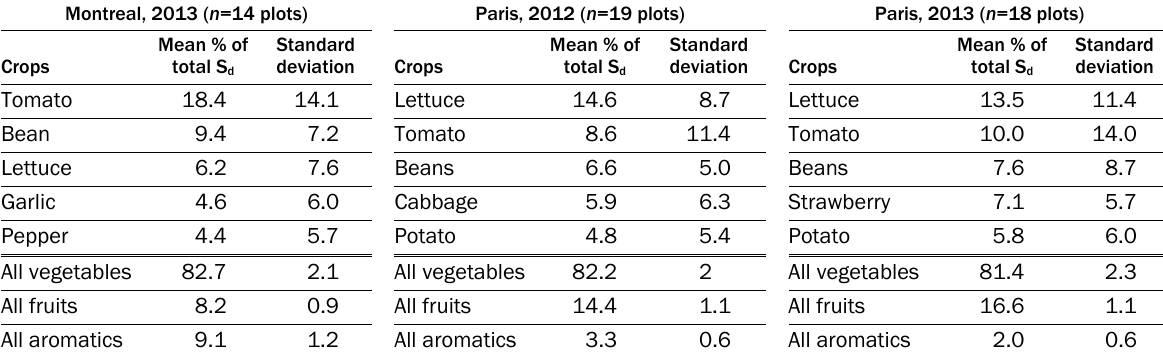
Table 4. Main Crops in Montreal and Paris Gardens (mean % of total S d ) Montreal, 2013 ( n =14 plots)